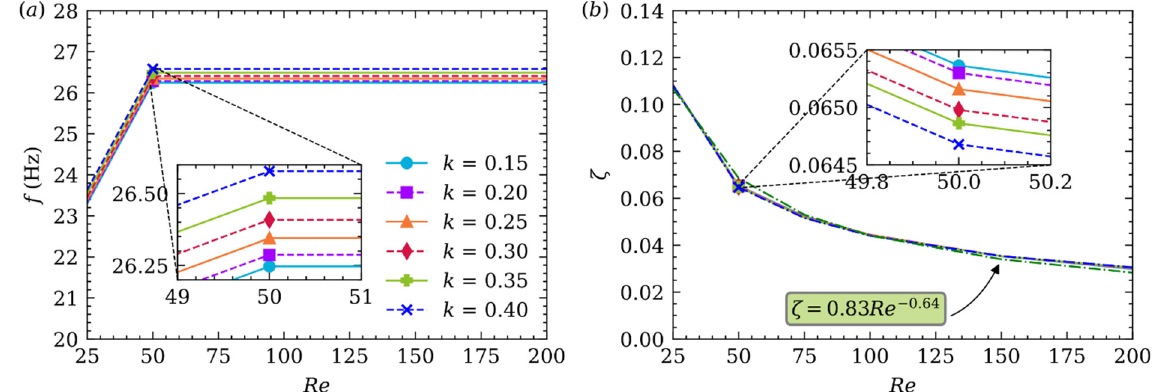
( a ) and damping ratio ( b ) at different Re and k Figure 12. The quasi frequency (cid:4666)𝐚(cid:4667) and damping ratio (cid:4666)𝐛(cid:4667) at different 𝑅𝑒 and 𝑘 . Figure 12. The quasi frequency